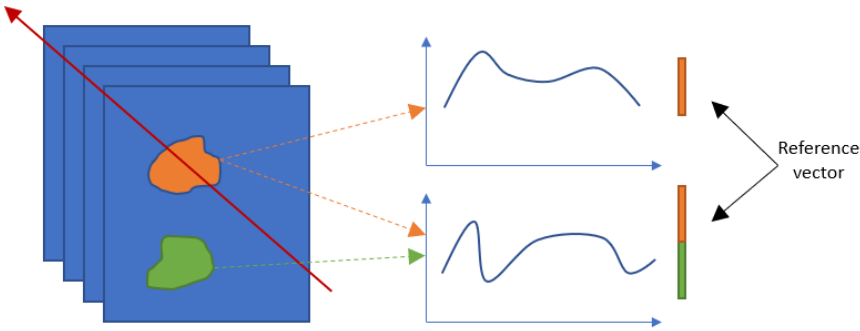
Figure 3. Schematic representation of the proposed active sampling methodology. The histogram entropy was calculated according to Equation (1). A new plot was Marked plots are ideally sampled to retrieve ground data. They can be used to tune added by appending its spectral content to the vector constituted by the one previously future sampling campaigns. In particular, the Pearson linear correlation coefficient [31] considered. In other words, the vectors representing the spectral response of the plots were between the average plot response and ground data is computed in order to guide the concatenated to form a longer one of k × n elements, where k is the number of available spectral features and n the number of plots considered. The entropy of the new histogram togram wa s computed considering only the spectral features showing a significant corre- was calculated and, if higher than the previous value, the plot was marked as selected for lation with the ground truth. field sampling. The procedure was repeated up to the end of available plots.